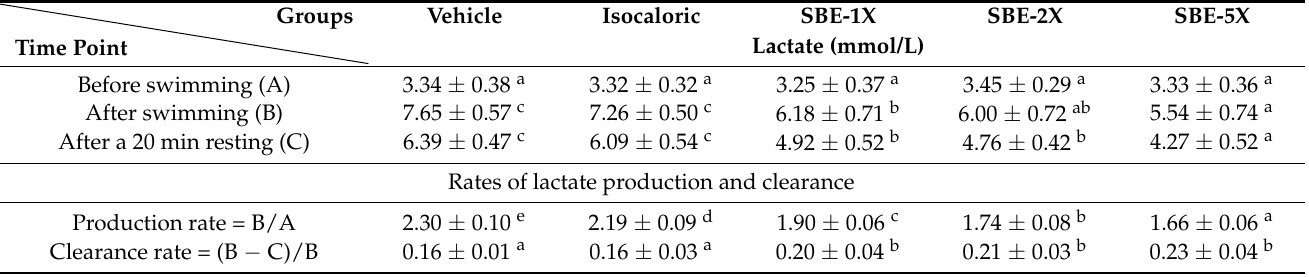
Table 1. Effects of SBE supplementation on serum levels of lactate after the 10-min